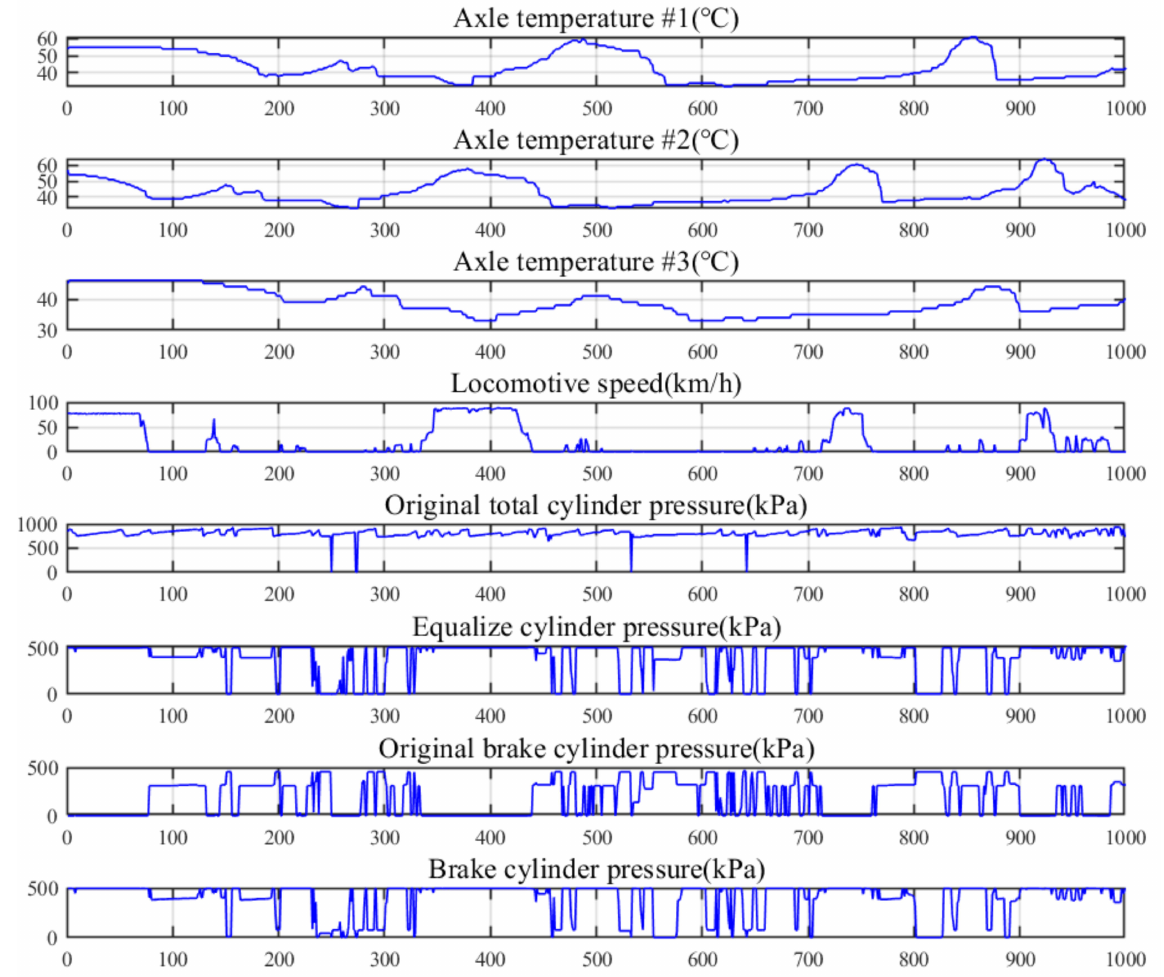
Figure 5. Raw temperature data #1, #2, and #3, and other data collected from a locomotive